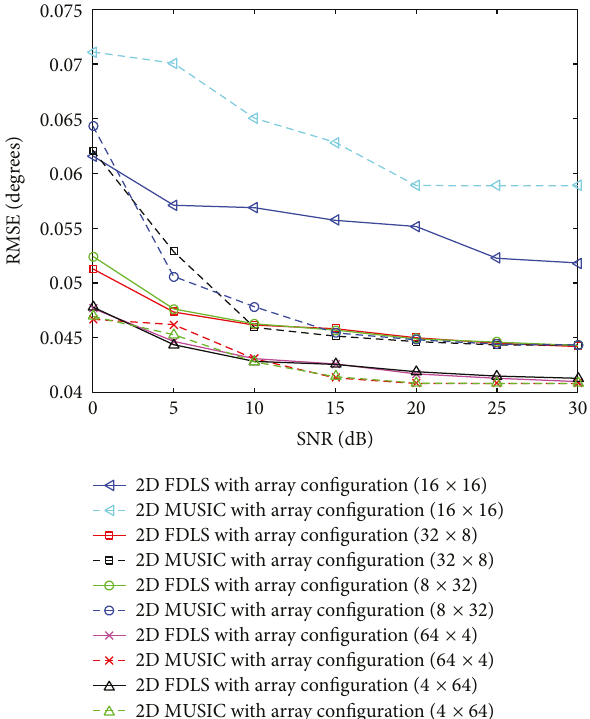
Figure 3: RMSE comparison between 2D MUSIC and 2D FDLS MUSIC algorithms for massive MIMO DOA estimation versus SNR for fi ve sources with di ff erent types of array con fi guration.